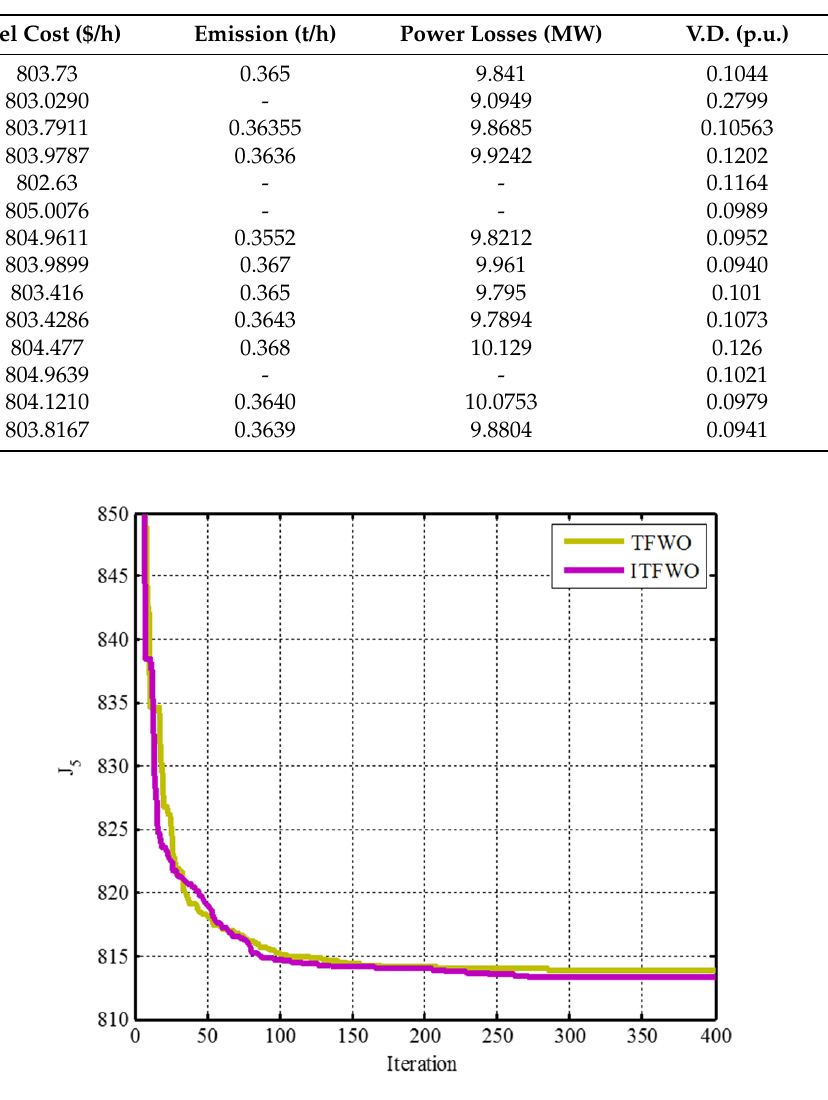
Figure 5. Optimization process for Type 3.